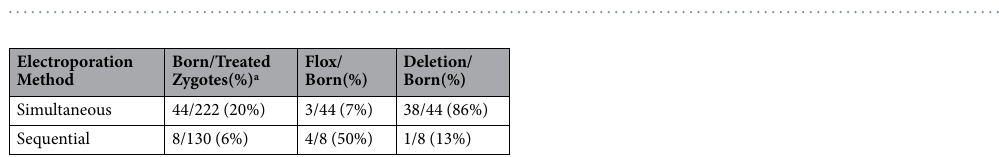
Table 3. Generation of Mecp2 Flox Mice. a Yield of mice (born/treated zygotes). b Samples that were not amplified by PCR were excluded because they could have contained chromosomal deletions. Detailed data are shown in Table S3.